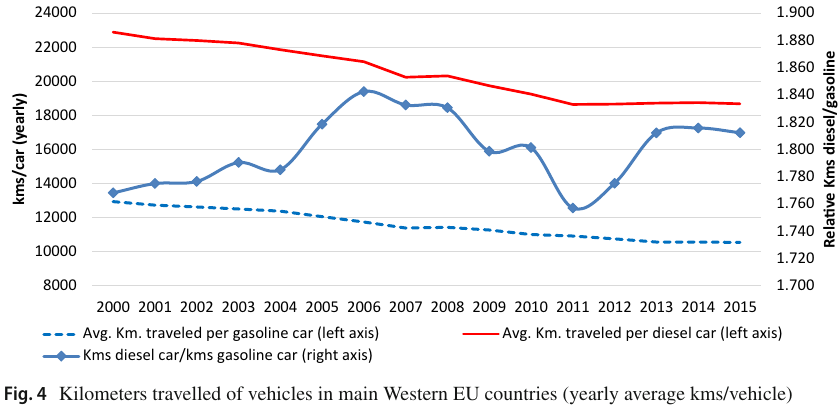
Fig. 4 Kilometers travelled of vehicles in main Western EU countries (yearly average kms/vehicle)